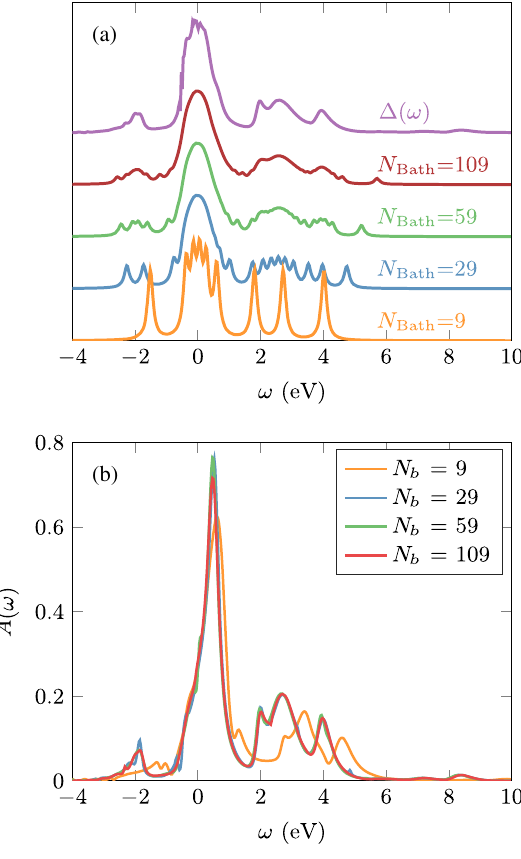
FIG. 4. (a) We take the bath spectral function Δ ð ω Þ from the 109 and represent it DMFT self-consistent solution for N b ¼ 9 is using various numbers of bath sites. It is obvious that N b ¼ too small to represent the bath well. (b) Converged DMFT spectral function using the AIM with different numbers of bath sites. Only the smallest bath shows a noticeable difference. This is mostly due to the fact that, in this case, a higher broadening of η 0 . 1 eV had to be used in the Fourier transform and time FT ¼ evolution was only possible for t ¼ 14 eV − 1 . The additional 59 bath sites is most likely a small structure at ω ¼ 0 for N b ¼ linear-prediction